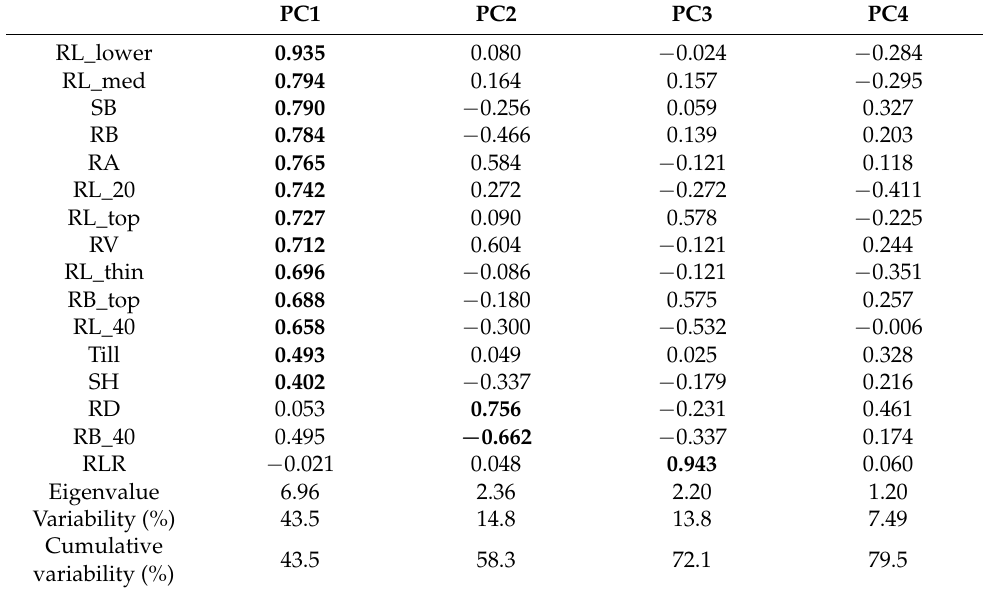
Table 4. Variable loading scores of 16 selected root and shoot traits (all CV ≥ 0.25, see Table 2) and the proportion of variation explained by each principal component. The highest value for each trait among the four components appeared in